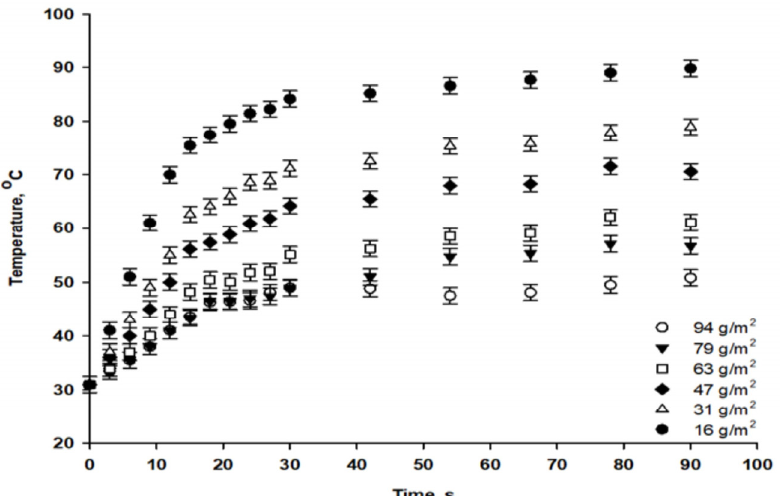
Figure 7. Temperature profile detected on the surface of coated papers at different coating weights (g/m 2 ) during infrared drying .